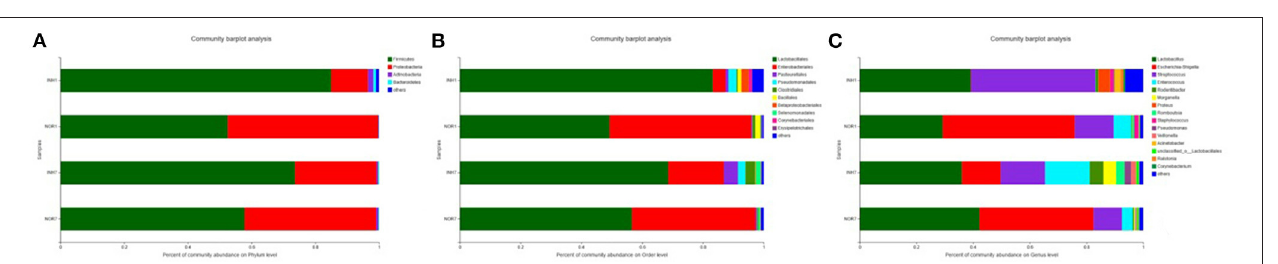
FIGURE 4 | (A) Bar plot of phylum-level community. (B) Bar plot of order-level community. (C) Bar plot of genus-level community. The vertical axis represents the sample name, the horizontal axis represents the proportion of species in the sample, the columns with different colors represent different species, and the length of the columns represents the proportion of the